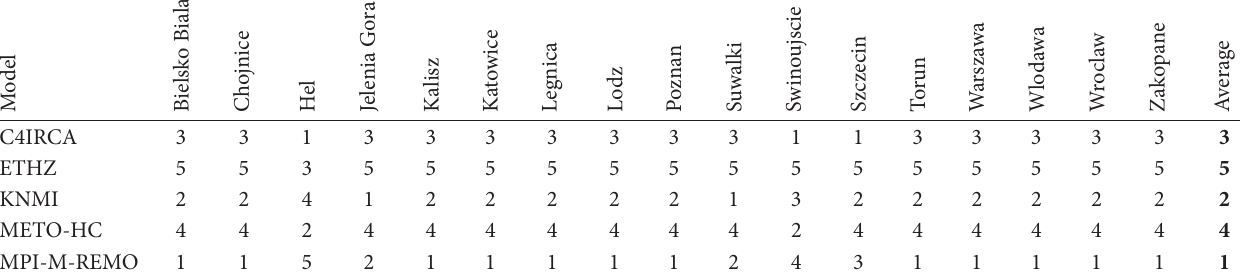
Table 2: Verification of models for temperature. The final ranks of models for all the stations and the mean ranks for Poland.